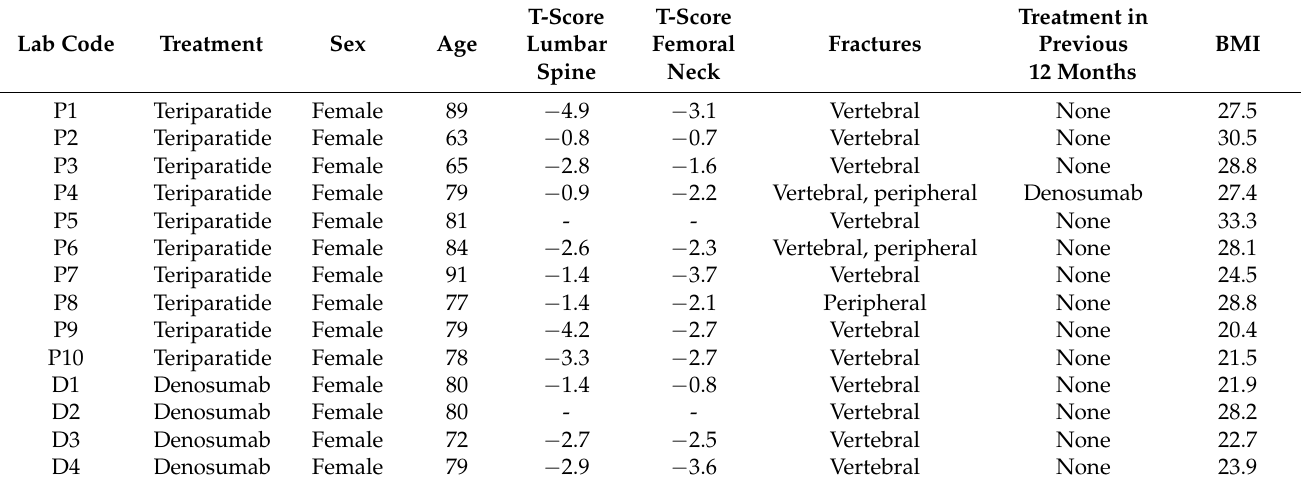
Table 5. Patients